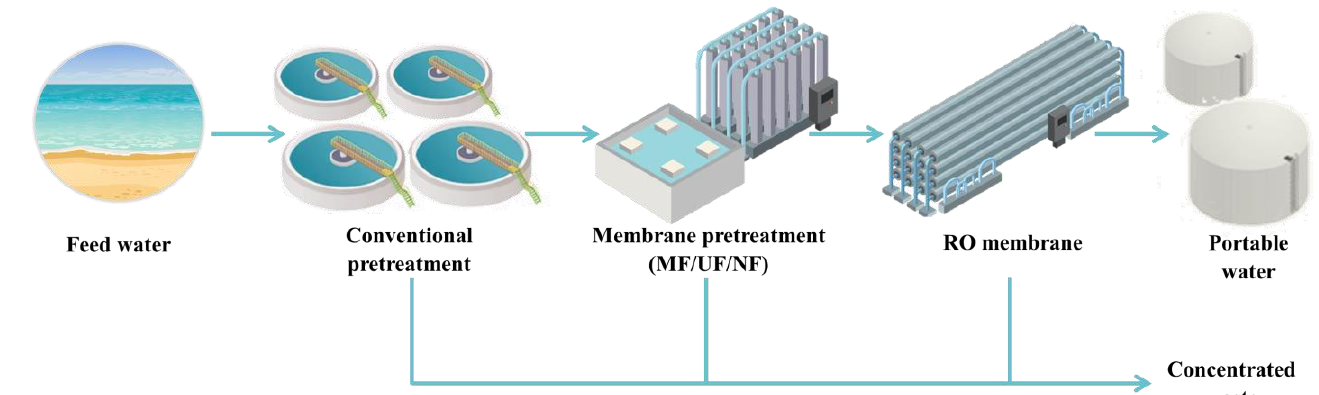
Figure 8. Typical SWRO setup using hybrid pretreatment systems.